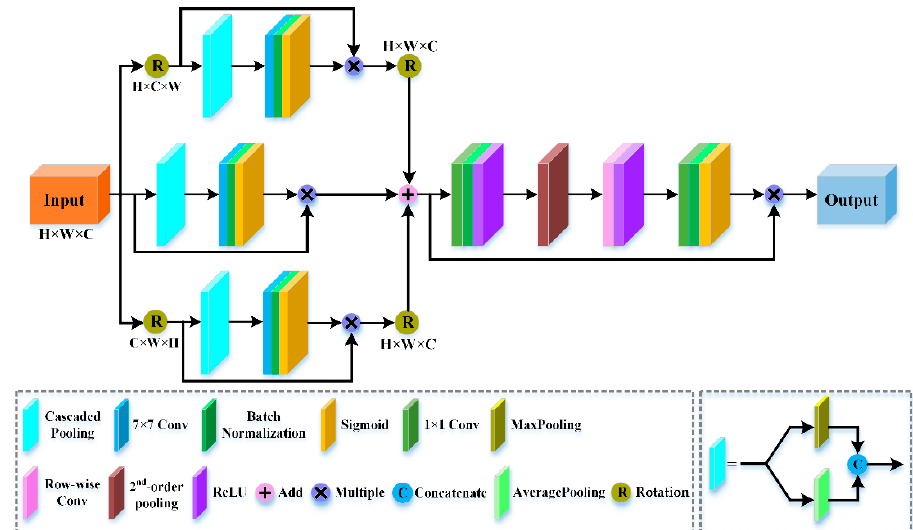
Figure 4. The structure of the feature rethinking module (FRM).